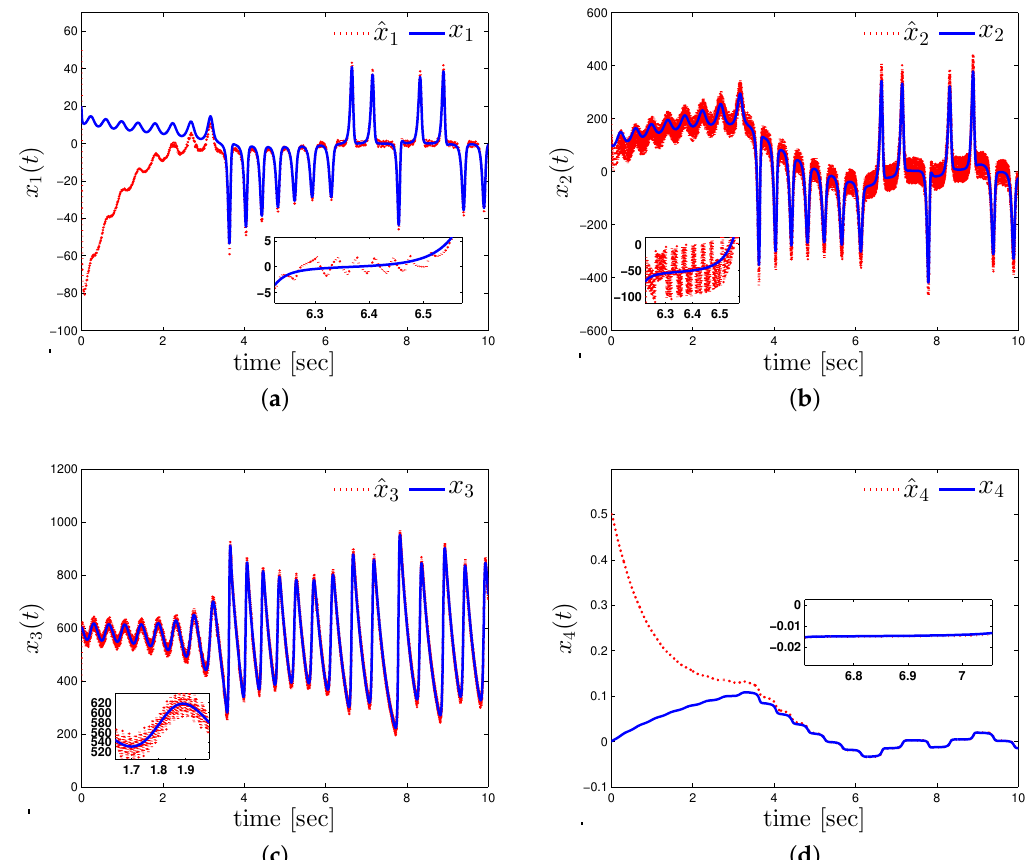
Figure 3. Actual (solid line) and estimated (doted line) values: ( a ) Dynamic of state x 1 and its estimated ˆ x 1 . ( b ) Dynamic of state x 2 and its estimated ˆ x 2 . ( c ) Dynamic of state x 3 and its estimated ˆ x 3 . ( d ) Dynamic of state x 4 and its estimated ˆ x 4